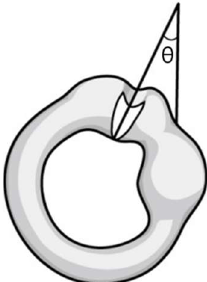
Figure 2. Left horizontal canal and cupula in the supine position (viewed from the front). θ: Angle between the cupula and perpendicular line.